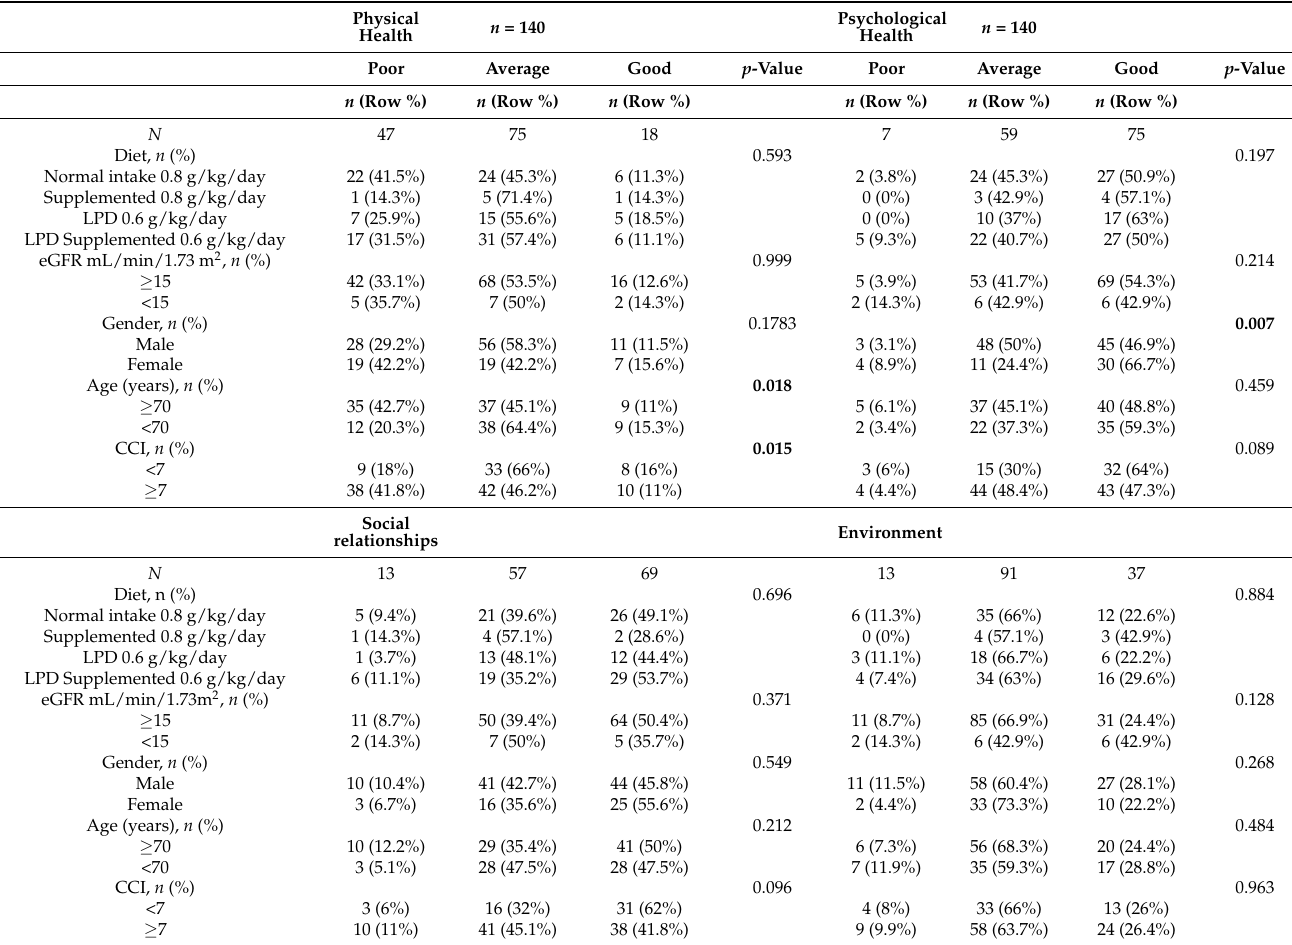
Table 4. Relationship between the main health determinants, diet and